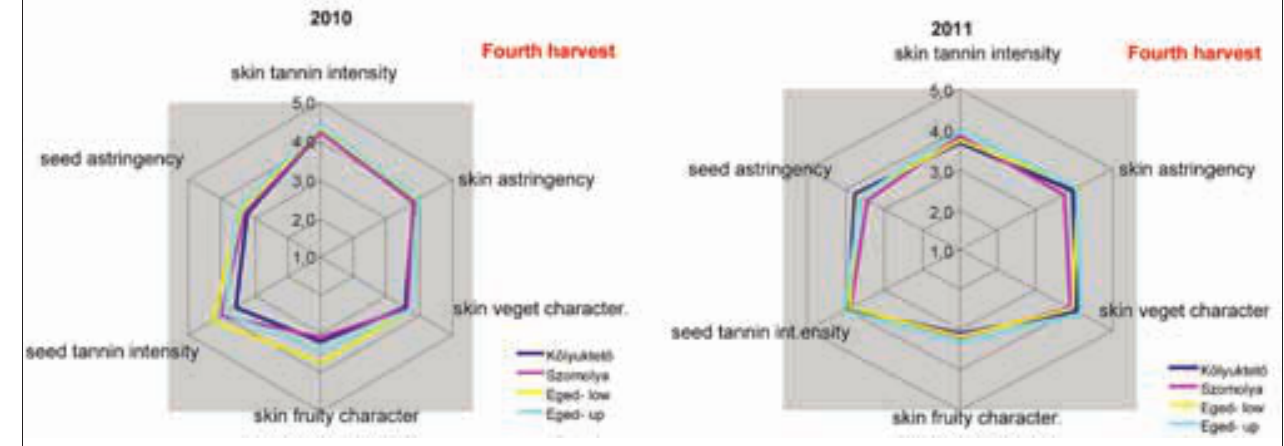
Figure 1 d: Main sensorial characters of the berry skin and the seeds (2010-2011- Fourth harvest time)